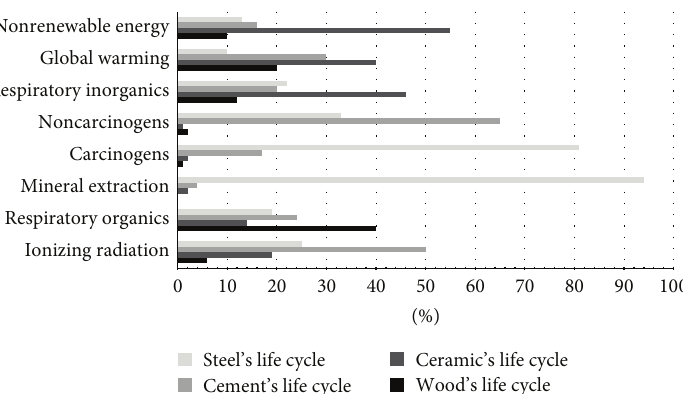
Figure 5: Comparison of the life cycles of selected materials, IMPACT2002+ method, and characterization [24].